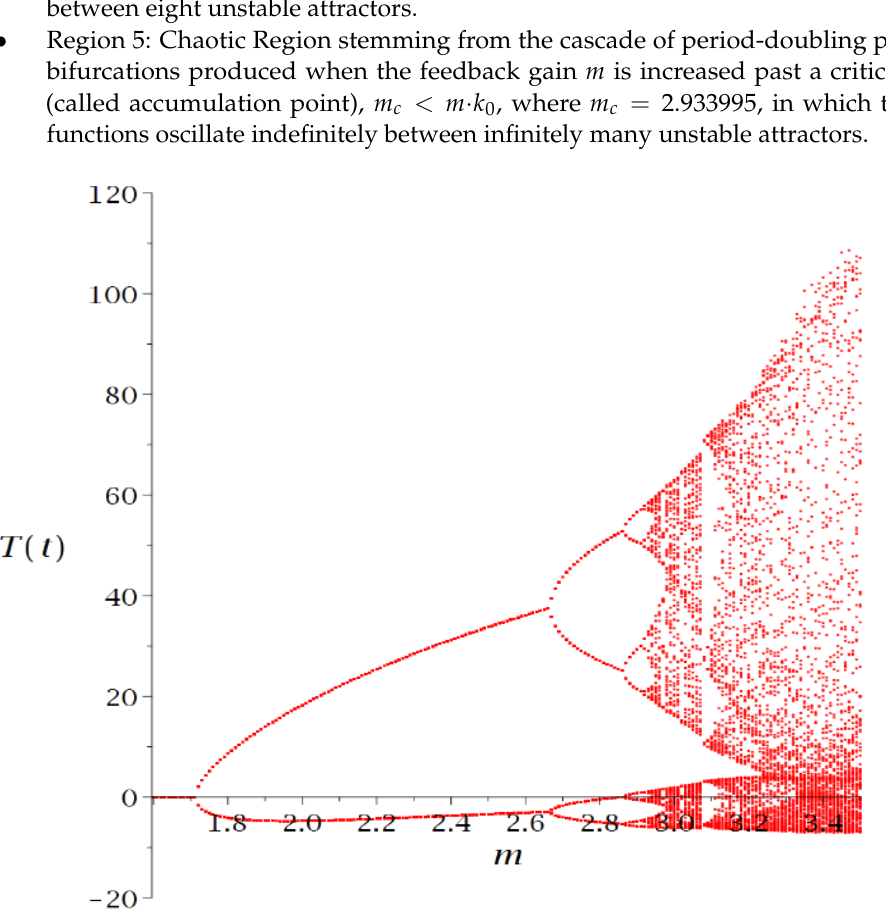
Figure 3. Bifurcation map of T ( t )